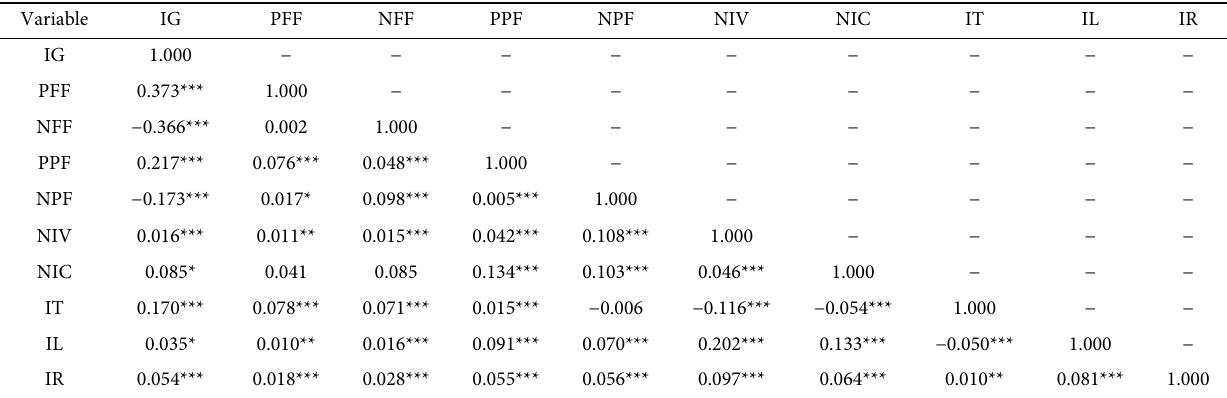
Table 2 Correlation matrix of variables (cross-section data).